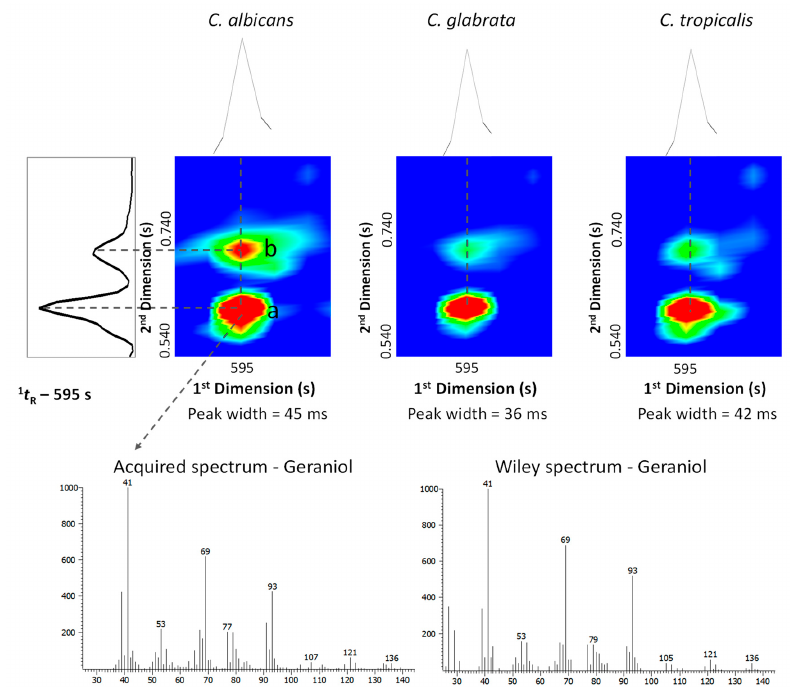
Figure 4. Blow-up of a part of GC×GC chromatogram contour plots from the C. albicans , C. glabrata and C. tropicalis (12 h) showing the separation, through the 2 D, of (a) geraniol (C 10 H 18 O) and (b) 2-isoamyl-6-methyl pyrazine (C 10 H 16 N 2 ), metabolites that exhibited the same retention time in the 1 D. The 36–45 milliseconds wide geraniol GC×GC peak was identified at a mass spectral acquisition of